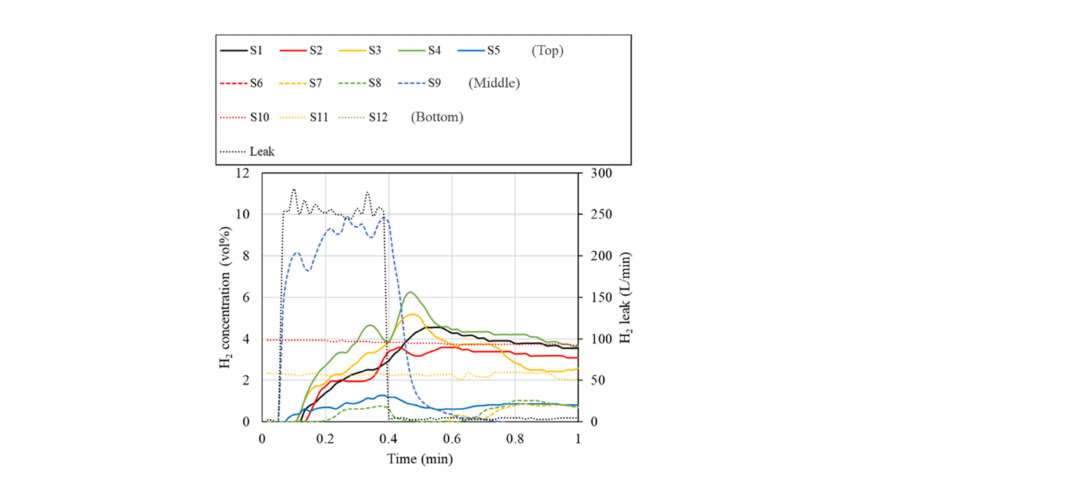
Figure 10. Hydrogen concentration variation by leak (Case 27: hydrogen supply pressure 3 kPa, leak